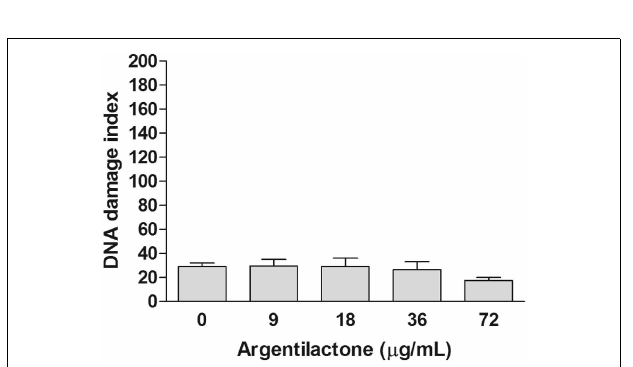
FIGURE 3 | Effect of argentilactone on P. lutzii cells growth. Yeast cells were cultured at 36 ◦ C in the absence (black) and presence (gray) of 9 µ g/mL argentilactone for 12h. Aliquots were taken and the cells were counted in a Neubauer chamber. * p < 0 . 05 .